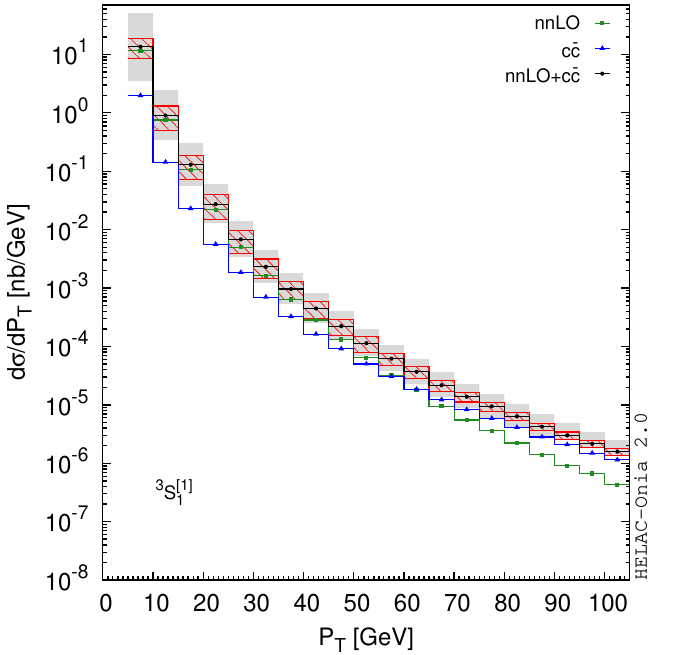
Figure 14 . Comparisons of spin-summed differential cross section d(cid:27) between our nnLO calculations and the LO charmonium plus charm quark pair calculations.